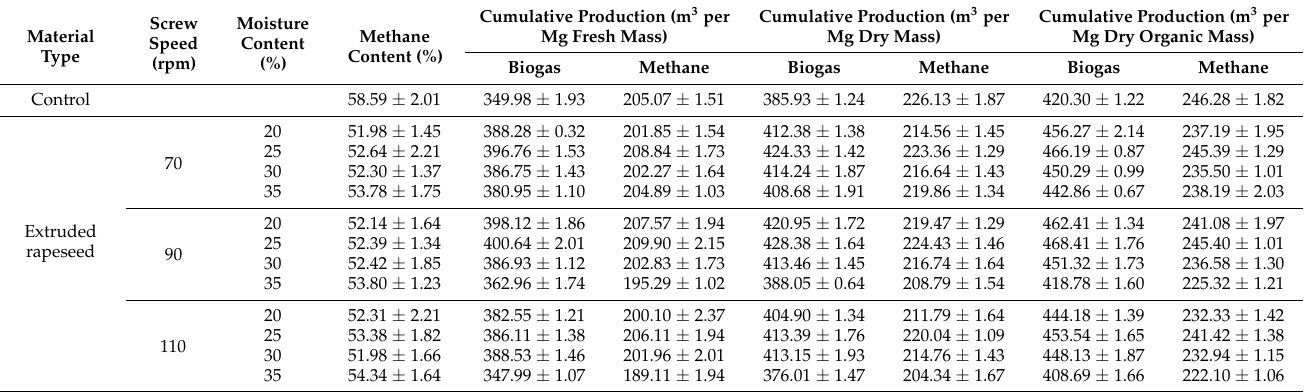
Table 8. Biogas efficiency of extruded rapeseed straw (after modification of the extruder screw; ±